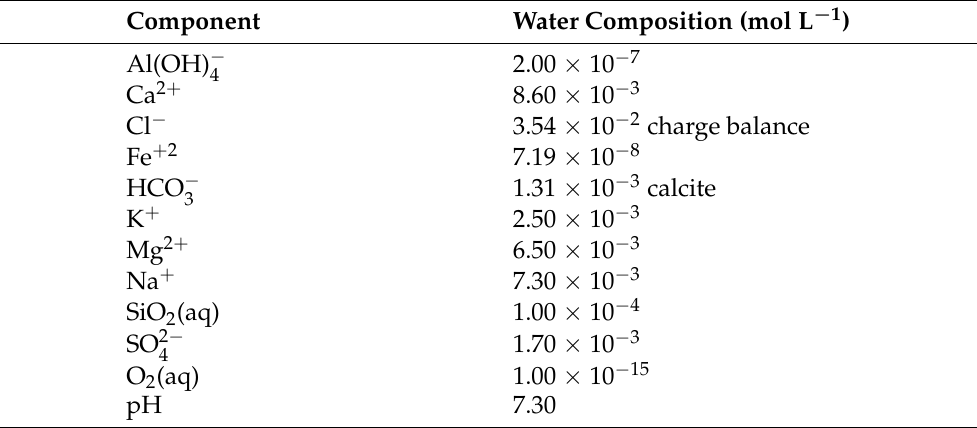
Table 3. MX-80 bentonite initial porewater composition used in the numerical model. Imposed constraints to calculate some of these values (equilibrium with solids and charge balance) are also indicated.